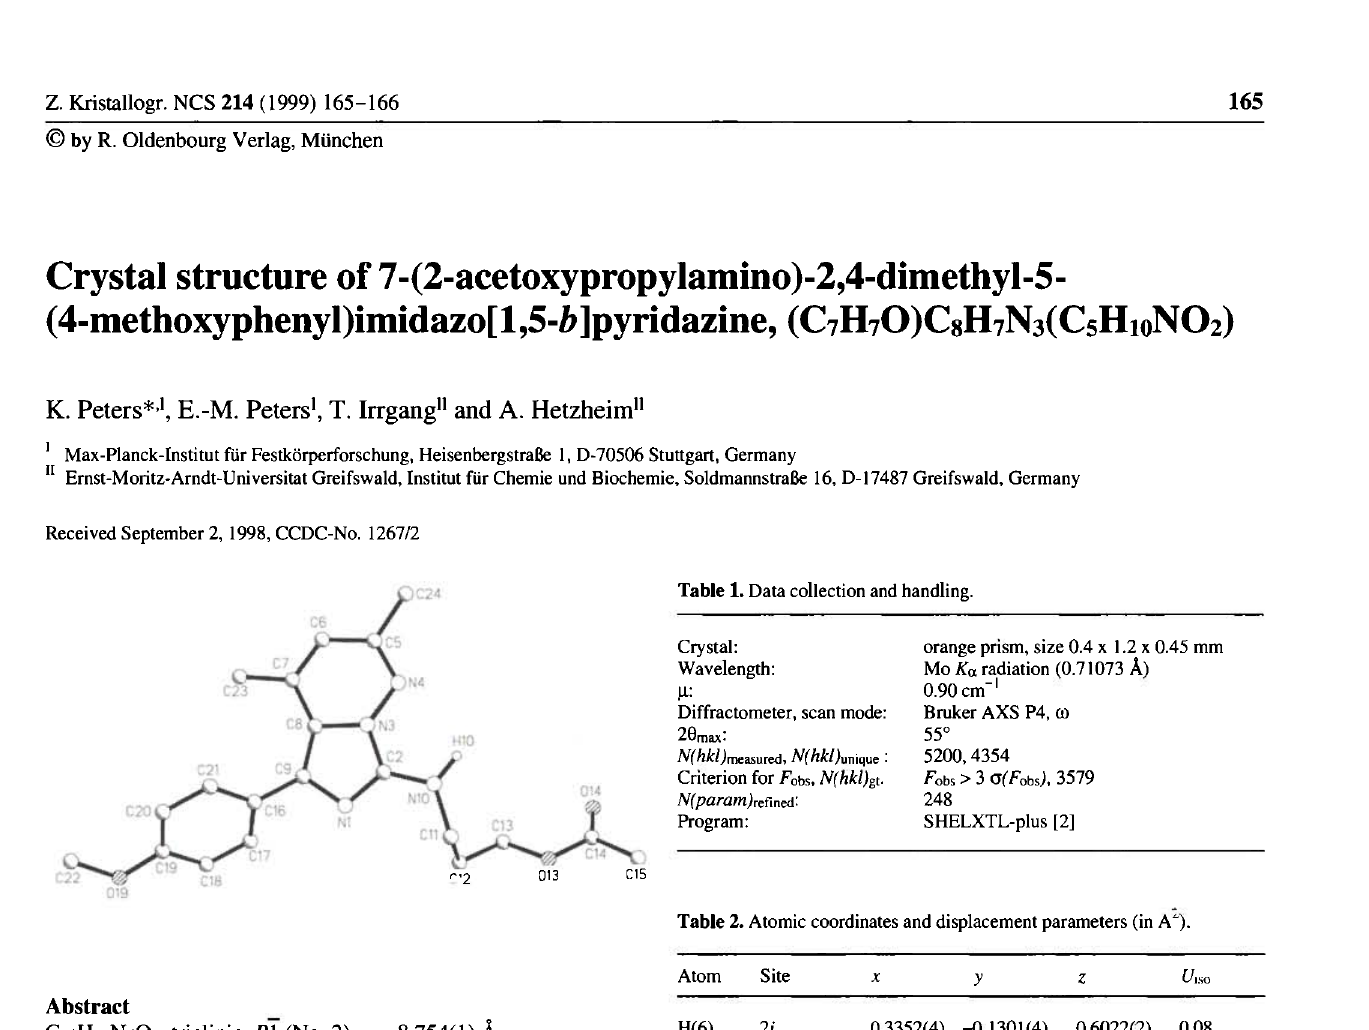
Table 2. Atomic coordinates and displacement parameters (in A ).